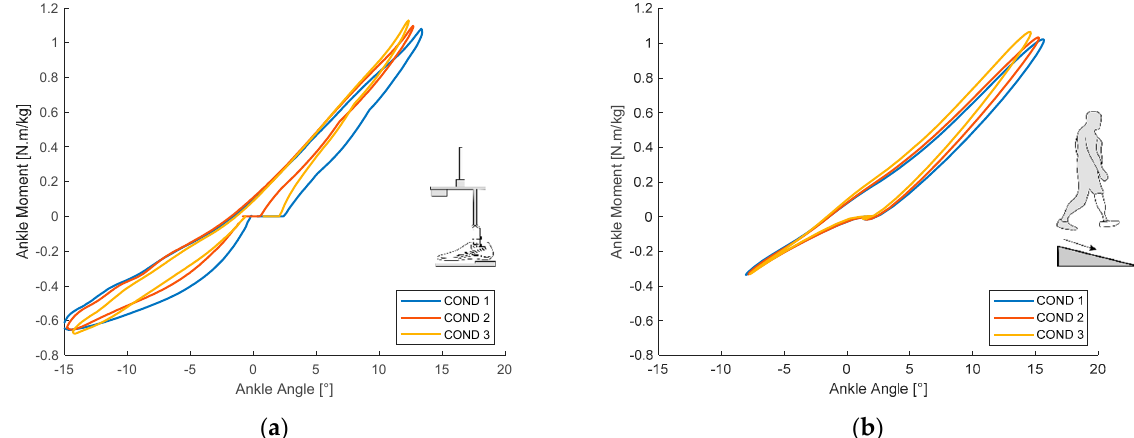
Figure 9. Ankle moment versus ankle angle during 7.5° decline walking for three stiffness settings-condition 1 (softest), condition 2 (mid), and condition 3 (stiffest): ( a ) test machine results and ( b ) biomechanical test results–average of five users. The maximum ankle angles for plantarflexion and dorsiflexion were recorded for each stiffness condition, task, and test method. The results are presented in Table 2. Table 2. Maximum ankle angles for plantarflexion and dorsiflexion in the test machine and biomechanical tests. Maximum Ankle Plantarflexion ( ◦ Condition